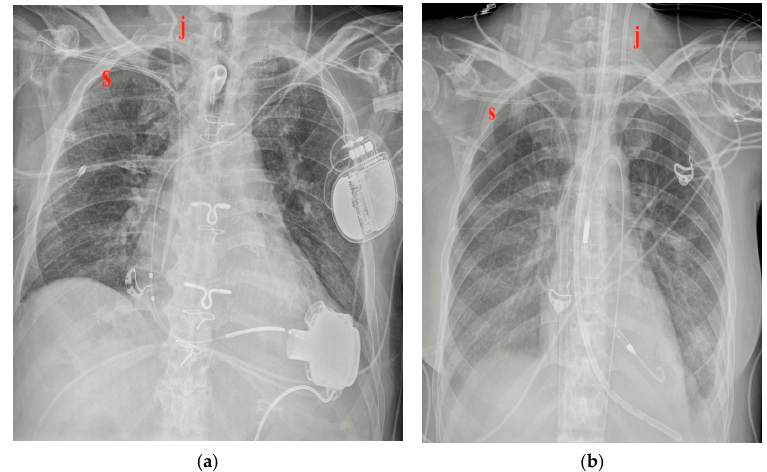
Figure 2. Two different CVC insertion points. ( a ) Right jugular CVC (marked “j”) seen as arising from the neck of the patient, together with a right subclavian CVC (marked “s” in red); note that the two tips of the catheters tend to overlap. ( b ) Subclavian right CVC (“s” in red) and a left jugular CVC (“j” in red). The tip of the catheter should be positioned into the superior vena cava (SVC) at the superior cavoatrial junction or in the right atrium [5]. The most common CXR-detectable complications are pneumothorax, malposition (looping, inferior vena cava (IVC) positioning of the tip, wrong thoracic vein positioning), or, less often, vascular perforation, with the catheter located inside the thorax (Figures 3– 5, Table 2) [6,7]. Table 2. Intravascular devices’ most frequent CXR-detectable anomalies and complications.